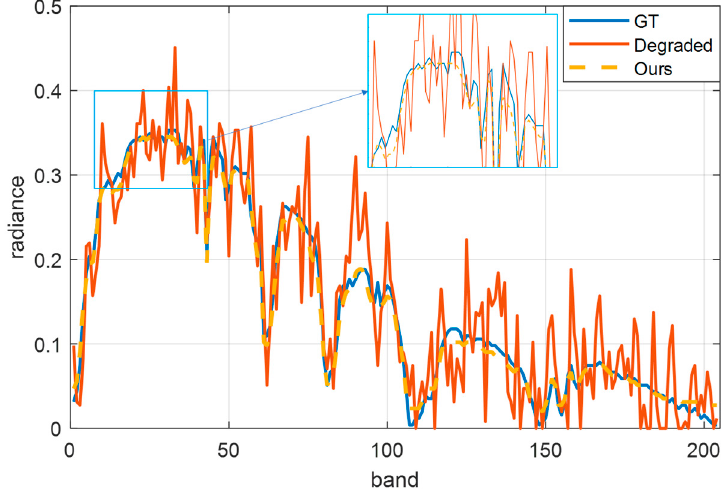
Figure 7. Spectral curve at (151,151) in the Salinas dataset. Blue represents the original spectral curve, red represents the degraded spectral curve, and yellow represents the spectral curve after quality improvement.